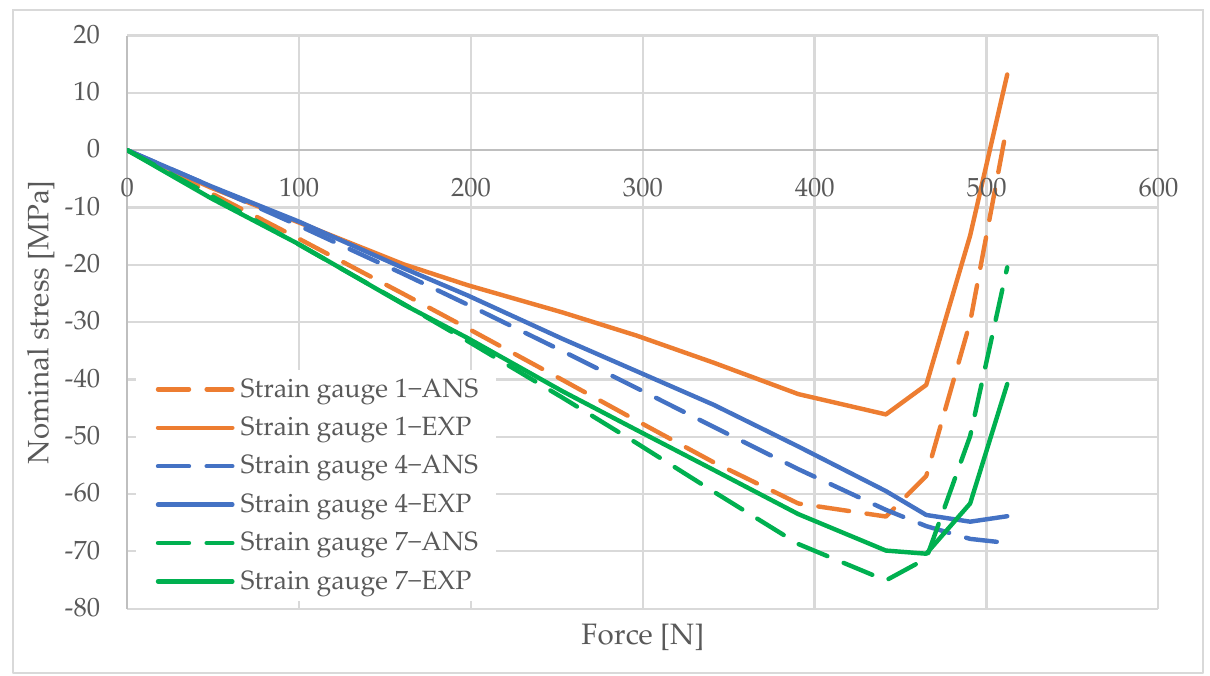
Figure 12. Pole 5/3 — values of normal stress readings from strain gauges no. 1, 4, and 7. Figure 12. Pole 5/3—values of normal stress readings from strain gauges no. 1, 4, and